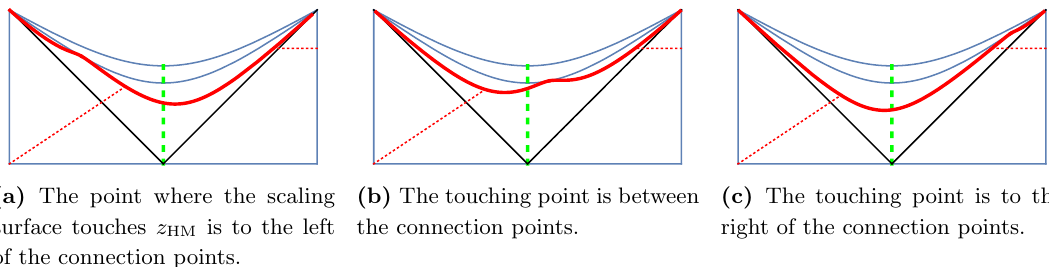
Figure 12. Doubled scaling surfaces in the d = 3 Schwarzschild black brane drawn with red on the Penrose diagram. The (cid:12)rst blue line behind the horizon is z = z HM . (The second is the singularity.) The scaling surface touches z HM at one point, where v = v shift . The connection of the scaling surface to the boundary does not contribute to the extensive part of the entropy, and is sketched with red dotted lines. The scaling surface area between the connection points is what computes the two-sided entropy. For this plot we chose (cid:26) c = 1 (for visualization purposes), but for the scaling surface to be a good approximation to the HRT surface, we have to choose a large (cid:26) c